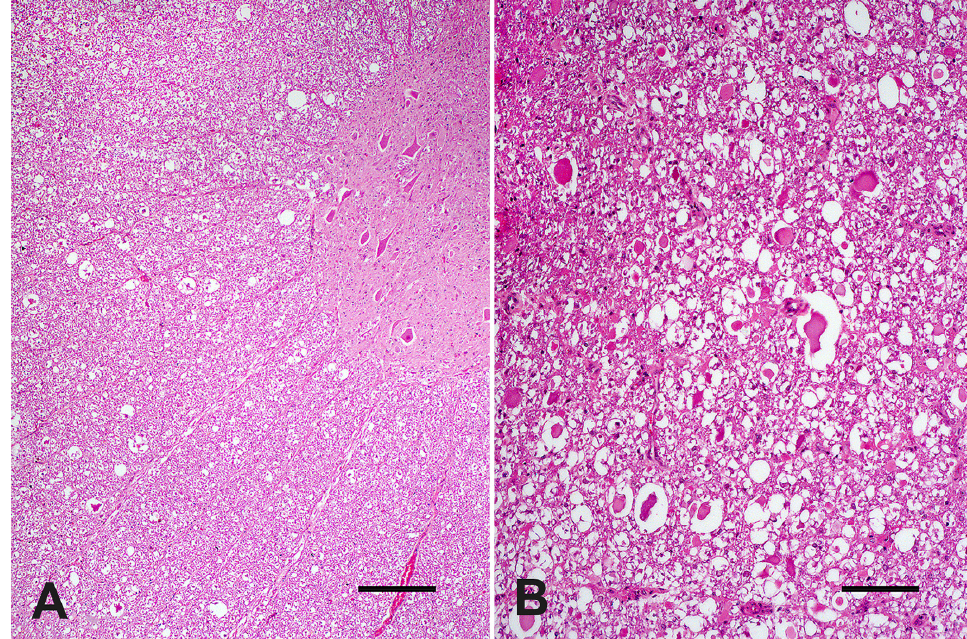
Figure 3. White matter of C3–C4 segment of the spinal cord of a four-month-old Nelore calf., ( A ) Multifocal areas of Wallerian degeneration (H&E, bar = 250 μ m). ( B ) A severely affected area close to the spinal cord surface with several axonal spheroids (H&E, bar = 100 μ m).